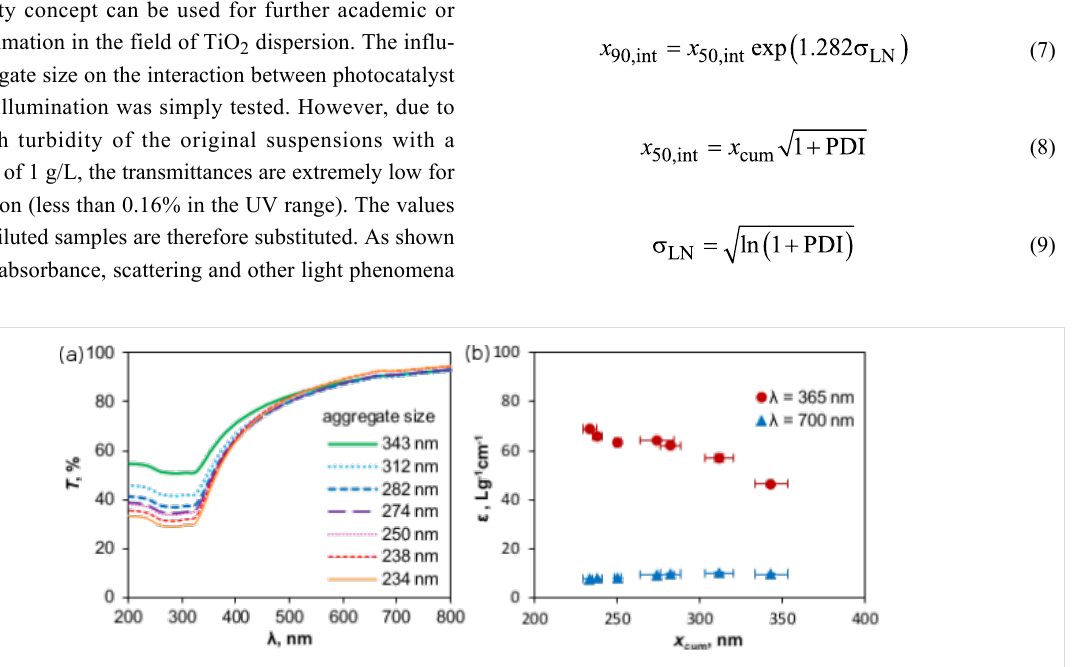
Figure 5: (a) Light transmittance ( T ) through a 1 cm optical path length and (b) extinction coefficient ( ε ) of 0.01 g/L P25 suspensions with the varia- tion of aggregate size (measurements were repeated three times and error bars indicate the standard deviation).